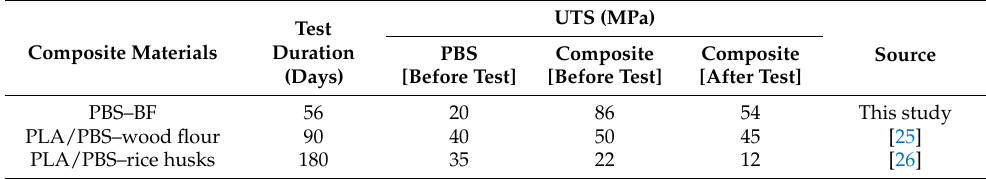
Table 1. Comparison of UTS of several PBS matrix-based biocomposites before and after biodegrada- tion